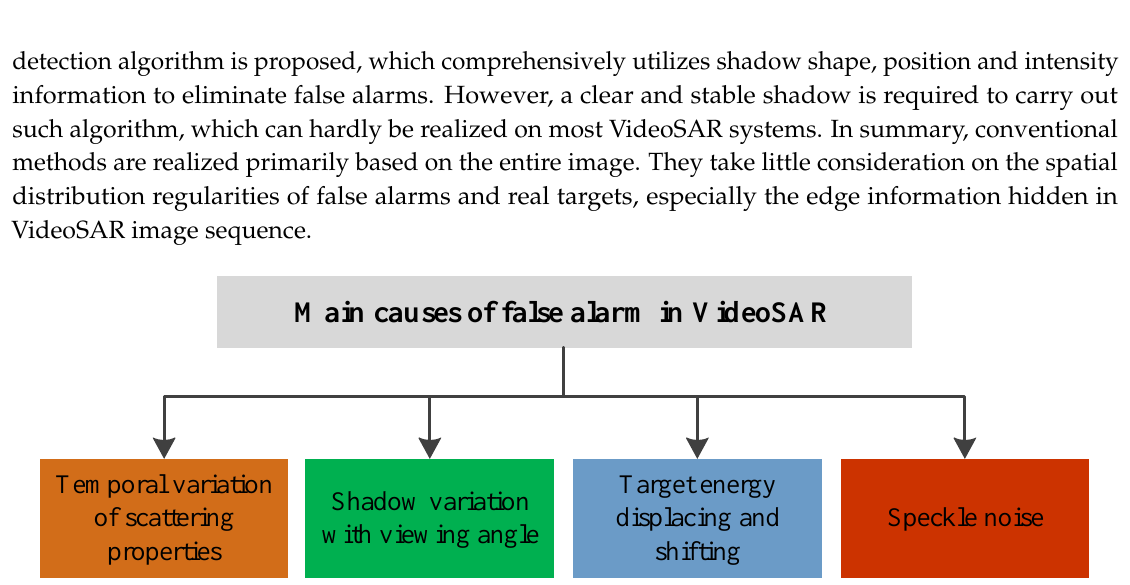
Figure 1. Main causes of false alarm in VIdeo syntehetic aperture